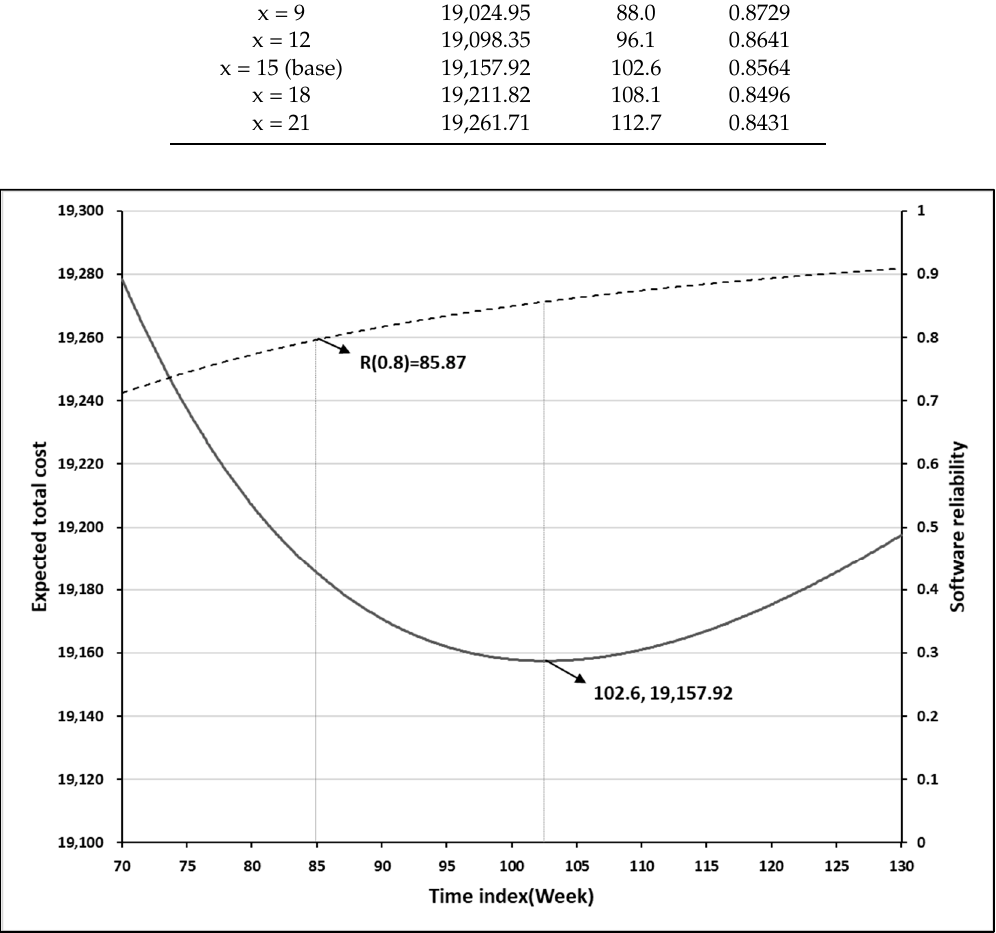
Figure 14. Expected total cost for the baseline case.